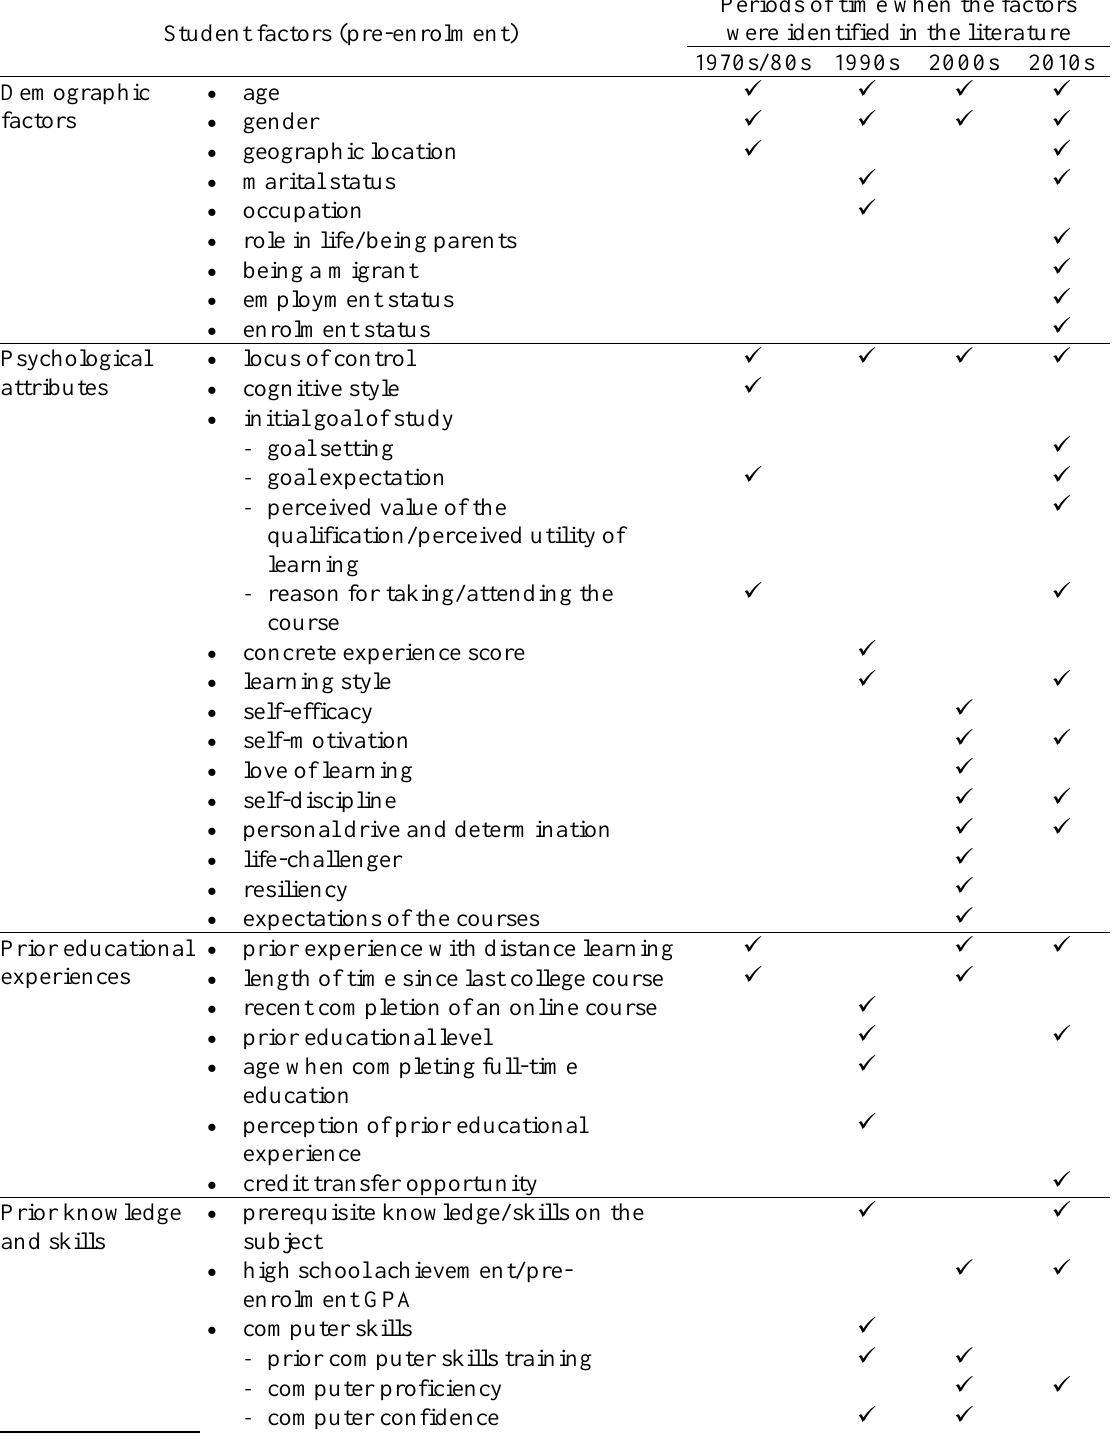
Table 2 Student Factors Affecting Persistence (Pre-Enrolment) Student factors (pre-enrolment)